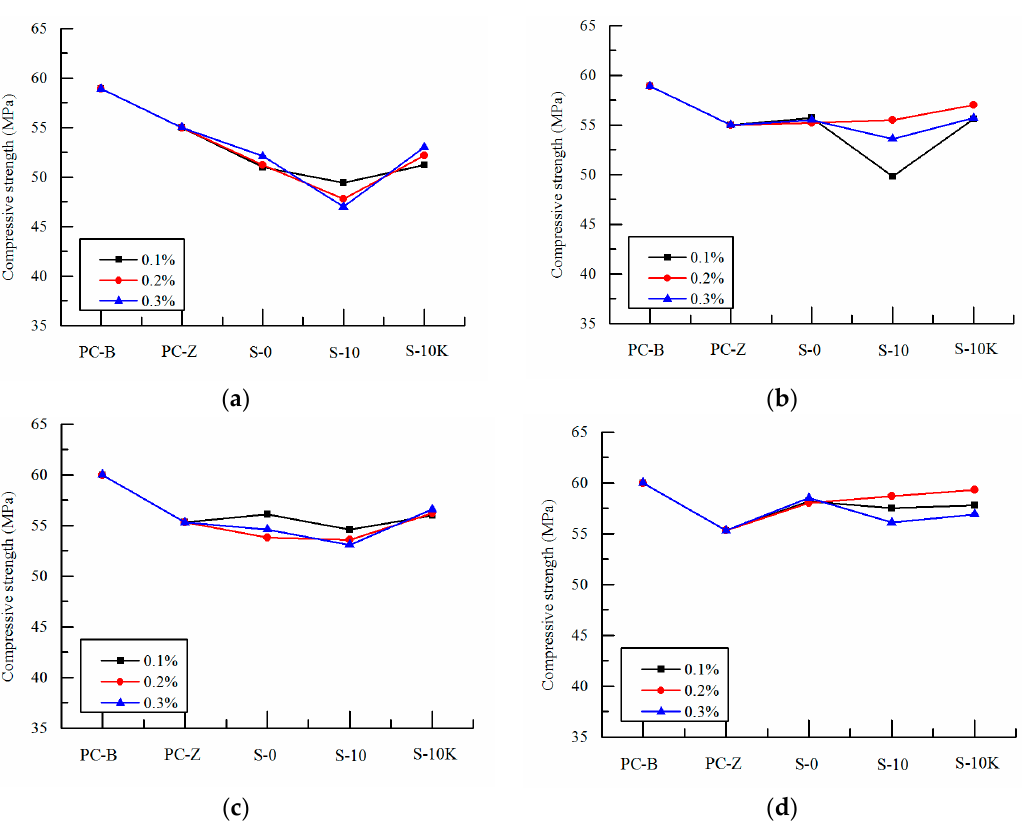
Figure 4. Effects of SAP on compressive strength of concrete at medium ages: ( a ) 28 days SAP-a; ( b ) 28 days SAP-b; ( c ) 56 days SAP-a; ( d ) 56 days SAP-b, S-10 and S-10K are pre-absorbed, and S-0 is non-absorbed.